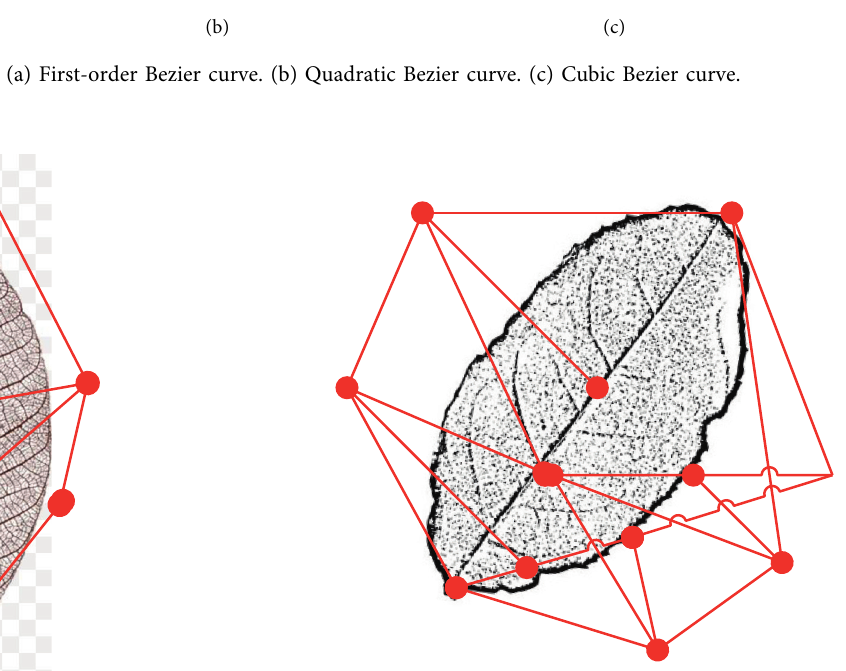
Figure 3: Bezier diagram of landscape plant microelements with lemma and palea as one.